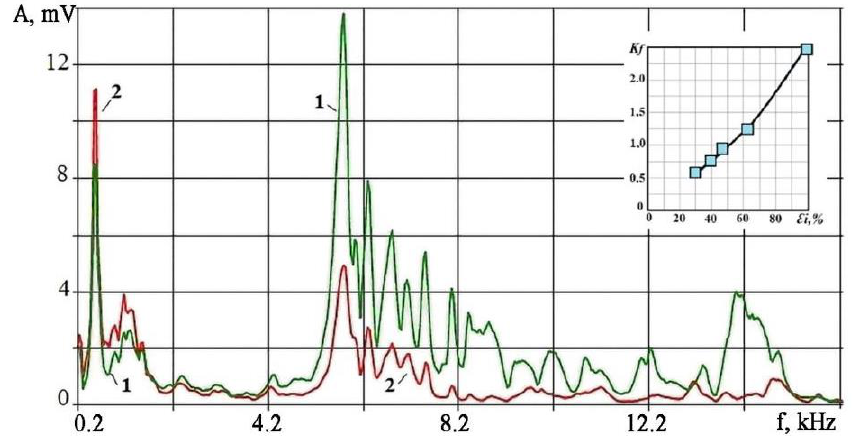
Figure 2. VA signal spectra during turning with sharp (spectrum 1) and worn (spectrum 2) inserts; the inset shows the change in the values of the K f parameter with an increase in the effect of wear on the surface layer deformation (horizontally shown is the surface layer deformation at a depth of 0.1 mm in percent).